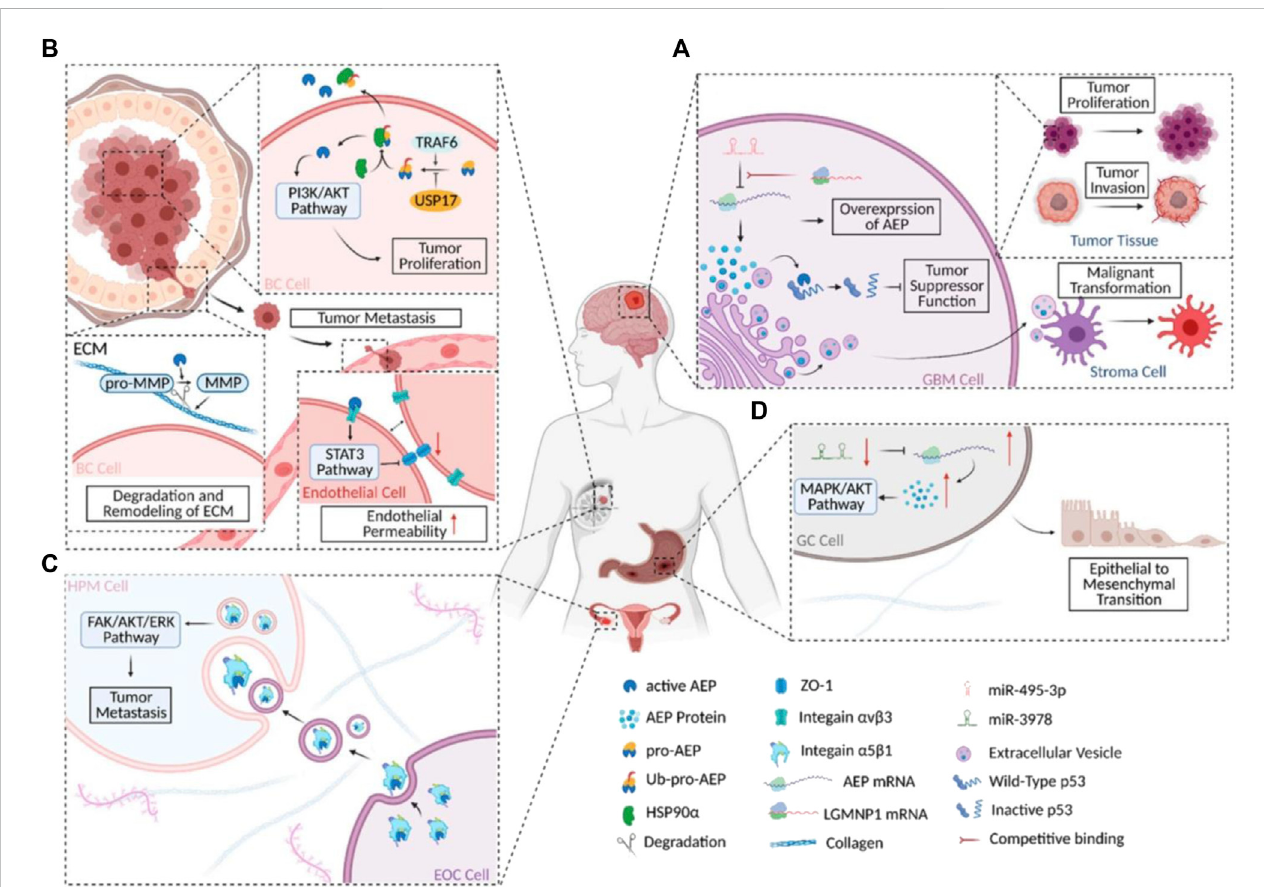
FIGURE 2 AEP ’ s functions in different carcinomas schematically. (A) AEP ’ s biochemical and regulatory mechanism in GBM. (B) AEP biochemistry and regulation in BC. (C) A simpli fi ed diagram depicting the molecular process and signaling pathway(s) involved in AEP ’ s action in EOC. (D) A simpli fi ed view of the signaling cascade and regulatory mechanism at work during AEP regulation in GC. this fi gure was reproduced under common creative licenses (Zhang and Lin,